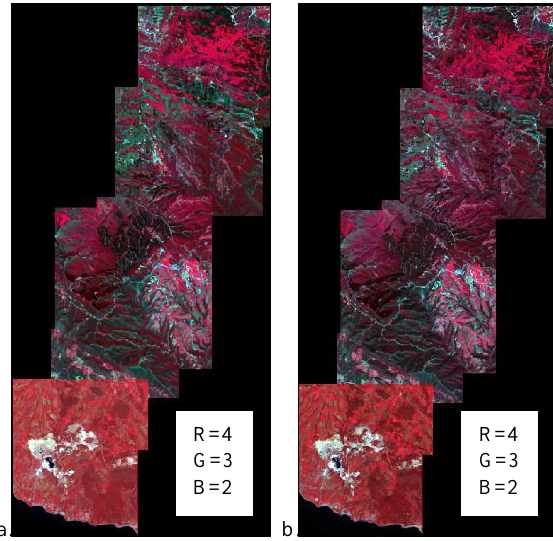
Figure 3. The Geoeye-1 MS stereo pairs (2m).